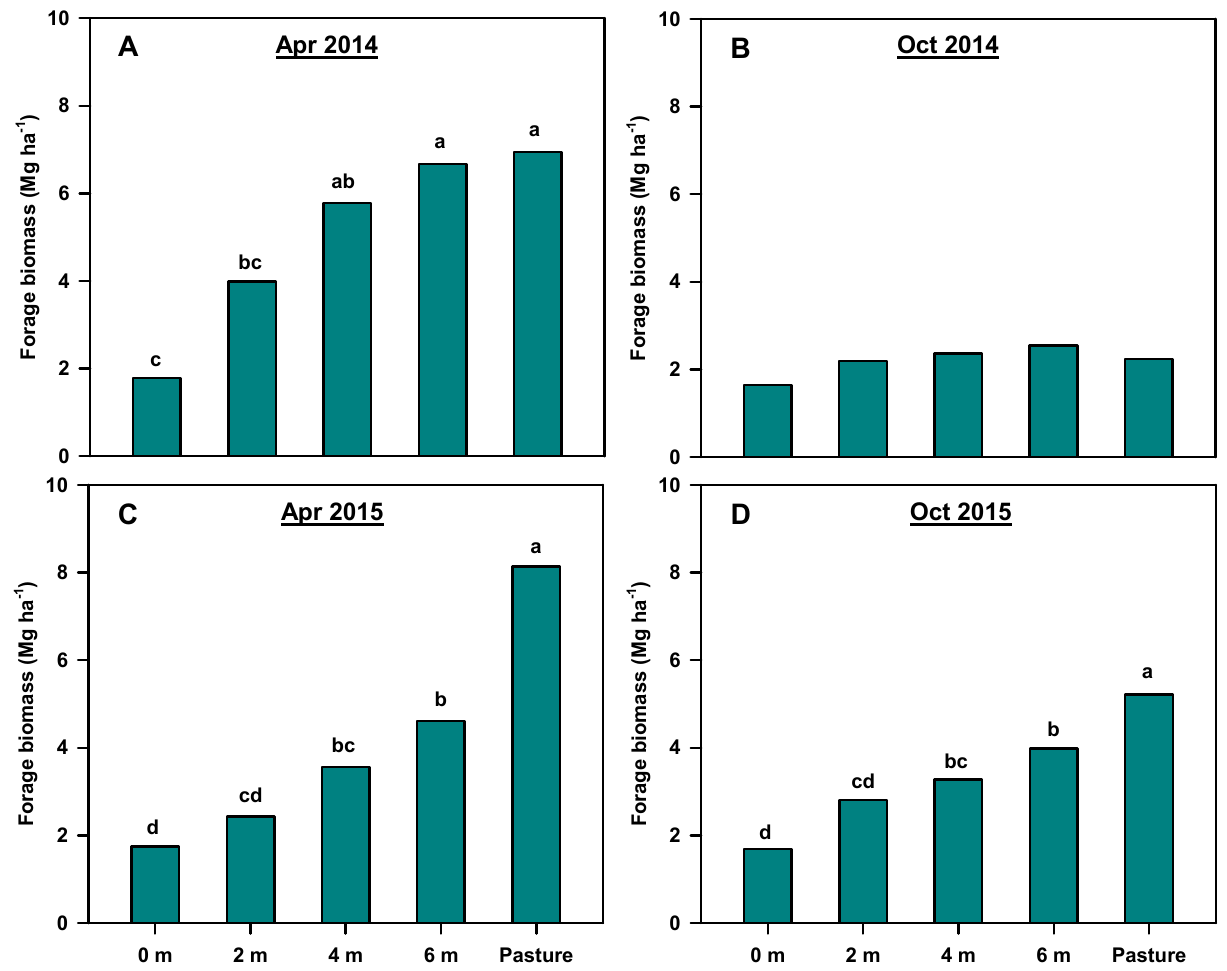
Figure 5. Production of dry matter biomass of the forage in ( A ) April and ( B ) October in 2014, and ( C ) April and ( D ) October in 2015 in the agroforestry systems and pasture. Means for forage in each season followed by the same letters do not differ significantly by the t -test (LSD), 5% probability. In April 2015 and October 2015, the forage biomass was significantly lower ( p < 0.05) in the agroforestry systems (3.0 Mg ha − 1 ) compared to the pasture (6.7 Mg ha − 1 ; Figure